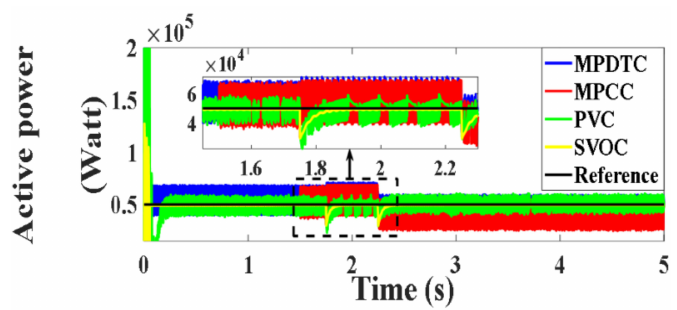
Figure 186. Comparison between active powers of four techniques (Watt).